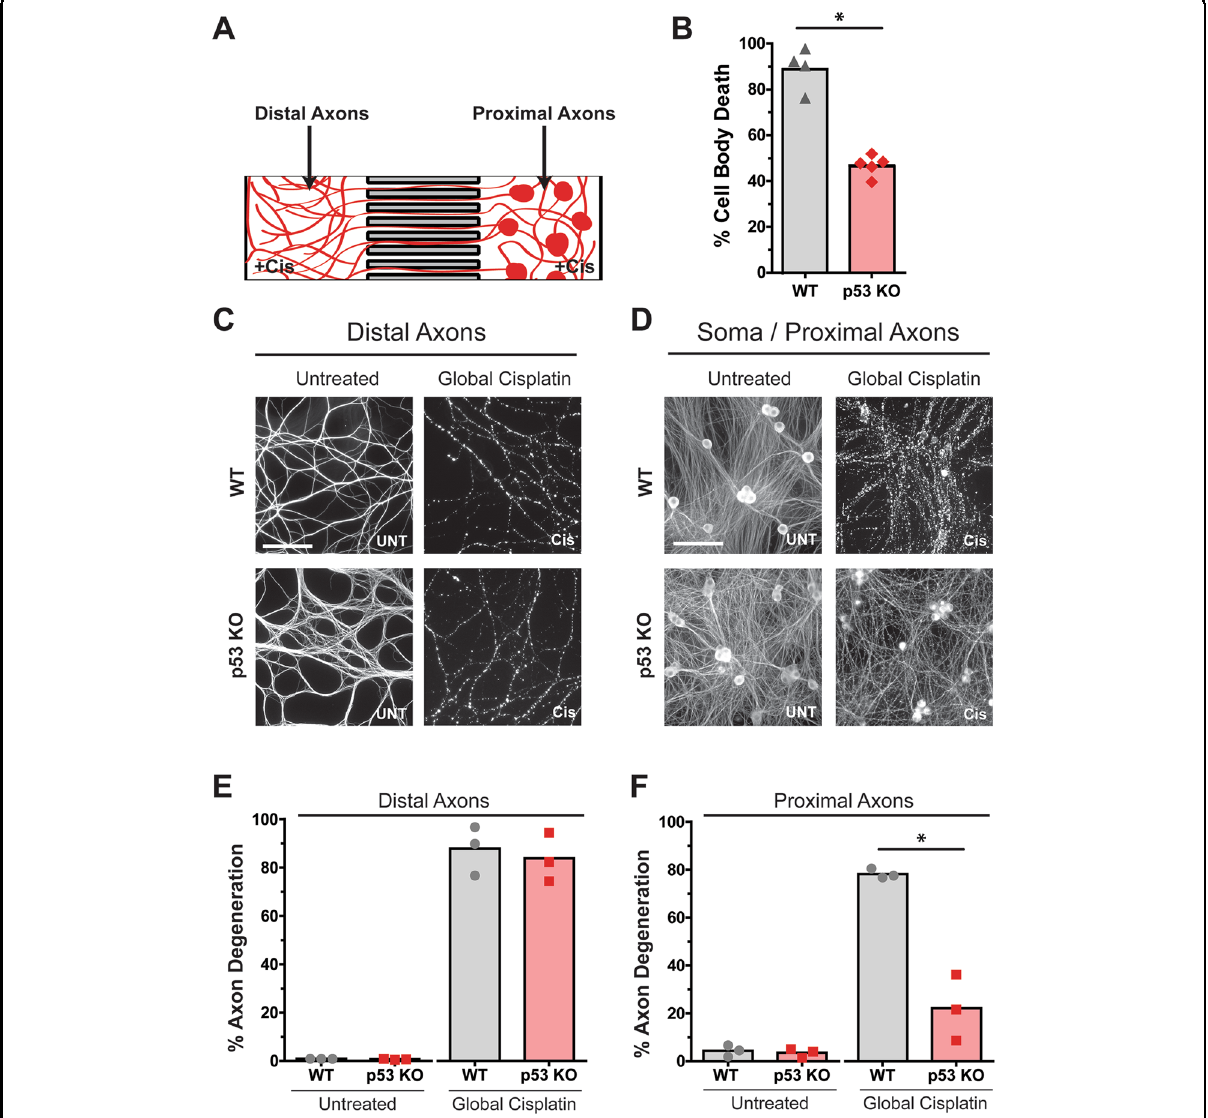
Fig. 6 p53 de fi ciency protects against soma loss from apoptosis but does not protect distal axons from mtDNA induced degeneration with whole cell cisplatin exposure. A Illustration of neurons (shown in red) in micro fl uidic chambers with cell bodies and proximal axons in the soma compartment on the right, and distal axons that have grown through the micro fl uidic grooves and extended into the axon compartment on the left. B – F Neurons isolated from p53-de fi cient mice were plated in micro fl uidic chambers and cisplatin was added to both soma and axon compartments (Global Cisplatin; 20 µM) to globally expose the whole cell to cisplatin for 96 h and stained for tubulin. The distal axons in the axon compartment are shown in C and the cell bodies and proximal axons are shown in D . Quanti fi cation of axon degeneration of C is shown in E ; and quanti fi cation of axon degeneration in D is shown in F , individual data points and mean are depicted. All experiments were conducted with an n = 3; Paired t -test (two-tailed) (* p < 0.05). The scale bar in C and D depicts 100 μ